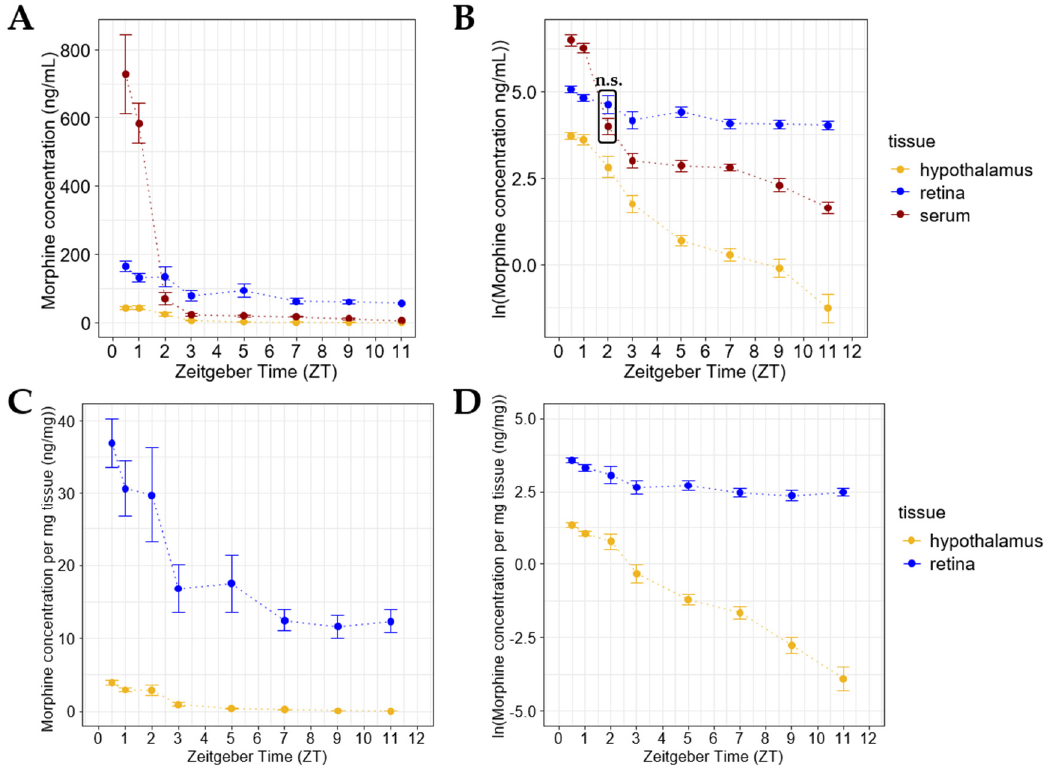
Figure 3. Morphine deposits more in the retina than in the hypothalamus following systemic administration. ( A ) Retinal morphine concentrations exceed hypothalamic morphine concentrations at all measured time points following a single i.p. morphine injection. ( B ) Morphine concentrations between the hypothalamus, retina, and serum were all significantly different at each measured time point following a single i.p. morphine injection ( p < 0.001), except for comparison shown in the box at ZT 2 (n.s. = not significantly different). Two-way ANOVA with a Tukey post hoc adjustment was performed on a natural logarithmic (ln) scale ( C , D ). Morphine concentration in the retina exceeds that detected in the hypothalamus when normalized against tissue weight at each measured time point following a single i.p. morphine injection ( p < 0.0001). ( D ) Two-way ANOVA with a Tukey post hoc adjustment was performed on an ln scale. Data are presented as the mean ± SEM, with 6–10 mice per